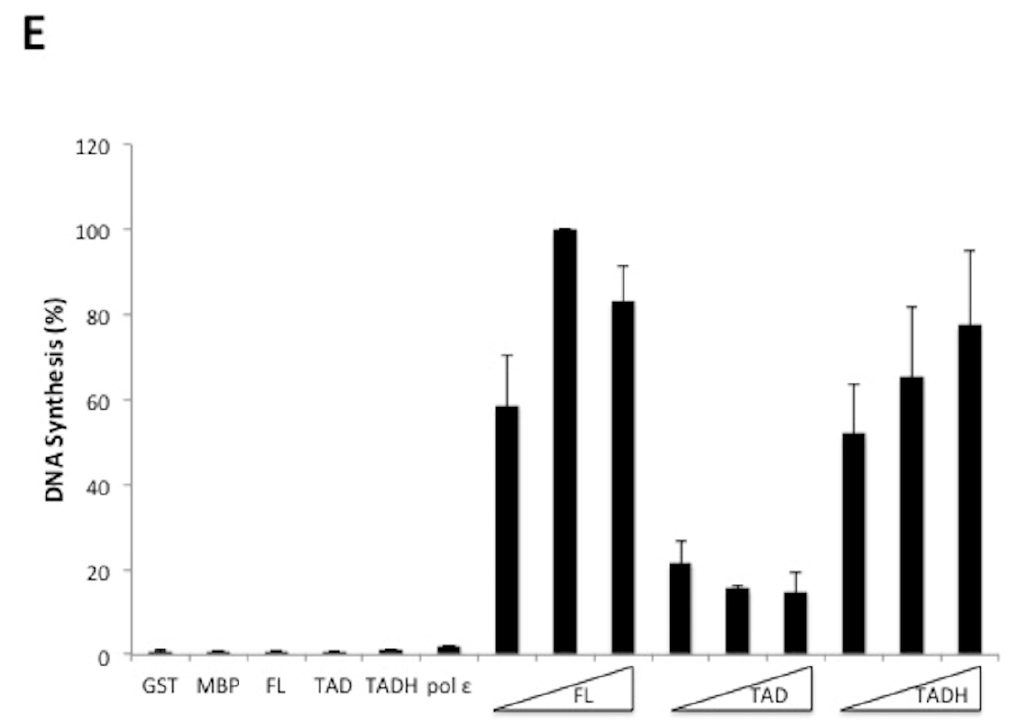
Figure 4. The TAD and hinge regions are important for stimulation of pol ε. ( A ) Various HPV 11 GST-E2 domain fusion proteins with MBP and GST were constructed and purified as described in the Methods. GST is approximately 200 amino acids, MBP is approximately 380 amino acids, and the orientation and relative size of each of the fusion proteins is pictorially represented. ( B ) 0.5 μg of each purified fusion protein was separated by SDS-PAGE and stained with Coomassie. ( C ) M13 primer extension assays were performed using 1 ng/μL of pol ε per reaction and 5, 10 and 20 pmoles of either MBP-E2 (lanes 4–6) or GST- E2 (lanes 8–10). Lanes 1 and 2 show the same gel size markers as described in Figure 1. ( D ) M13 primer extension assays were performed using 1 ng/μL of pol ε per reaction and 5, 10, and 20 pmoles of protein (FL), lanes 11–13 represent the GST-tagged transactivation domain (TAD), lanes 14–16 and 29–32 represent MBP-tagged transactivation-hinge domains (TADH), lanes 15–18 represent GST-tagged hinge (H), lanes 21–24 represent the GST-tagged hinge-DNA-binding domain (HDBD) and lanes 25–28 represent